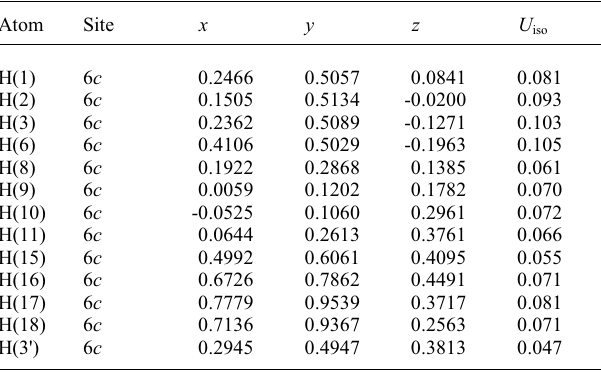
Table 2. Atomic coordinates and displacement parameters (in Å 2 ) .